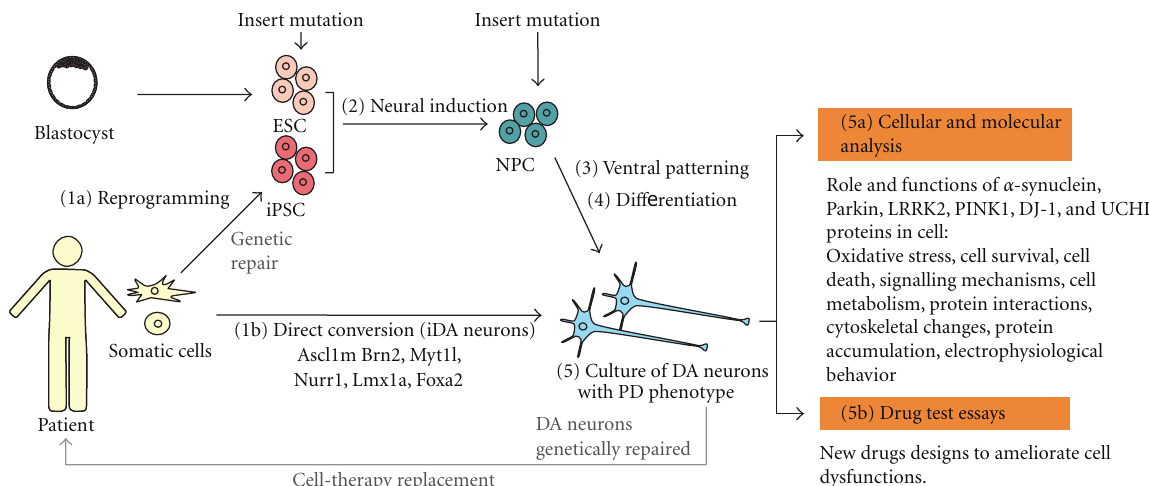
Figure 1: Possible cellular sources for modeling Parkinson’s disease in vitro . Somatic cells from patient with PD can be reprogrammed into iPSC and di ff erentiated into mesencephalic dopaminergic neurons (1a)–(5). ESC and NPC can be genetically modified by inserting specific mutations related with PD and be di ff erentiated. Alternatively, somatic cells can be directly converted into dopaminergic neurons